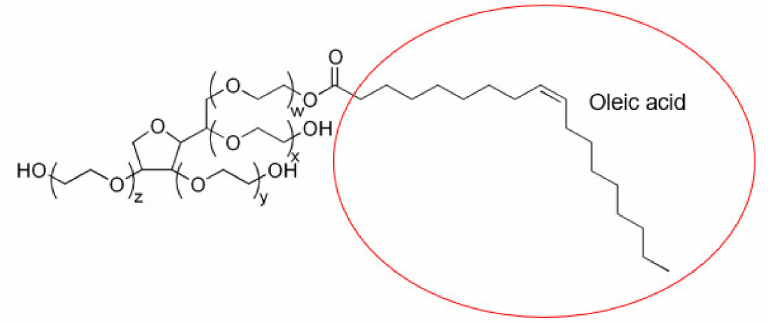
Figure 17. Chemical structure of PS20.